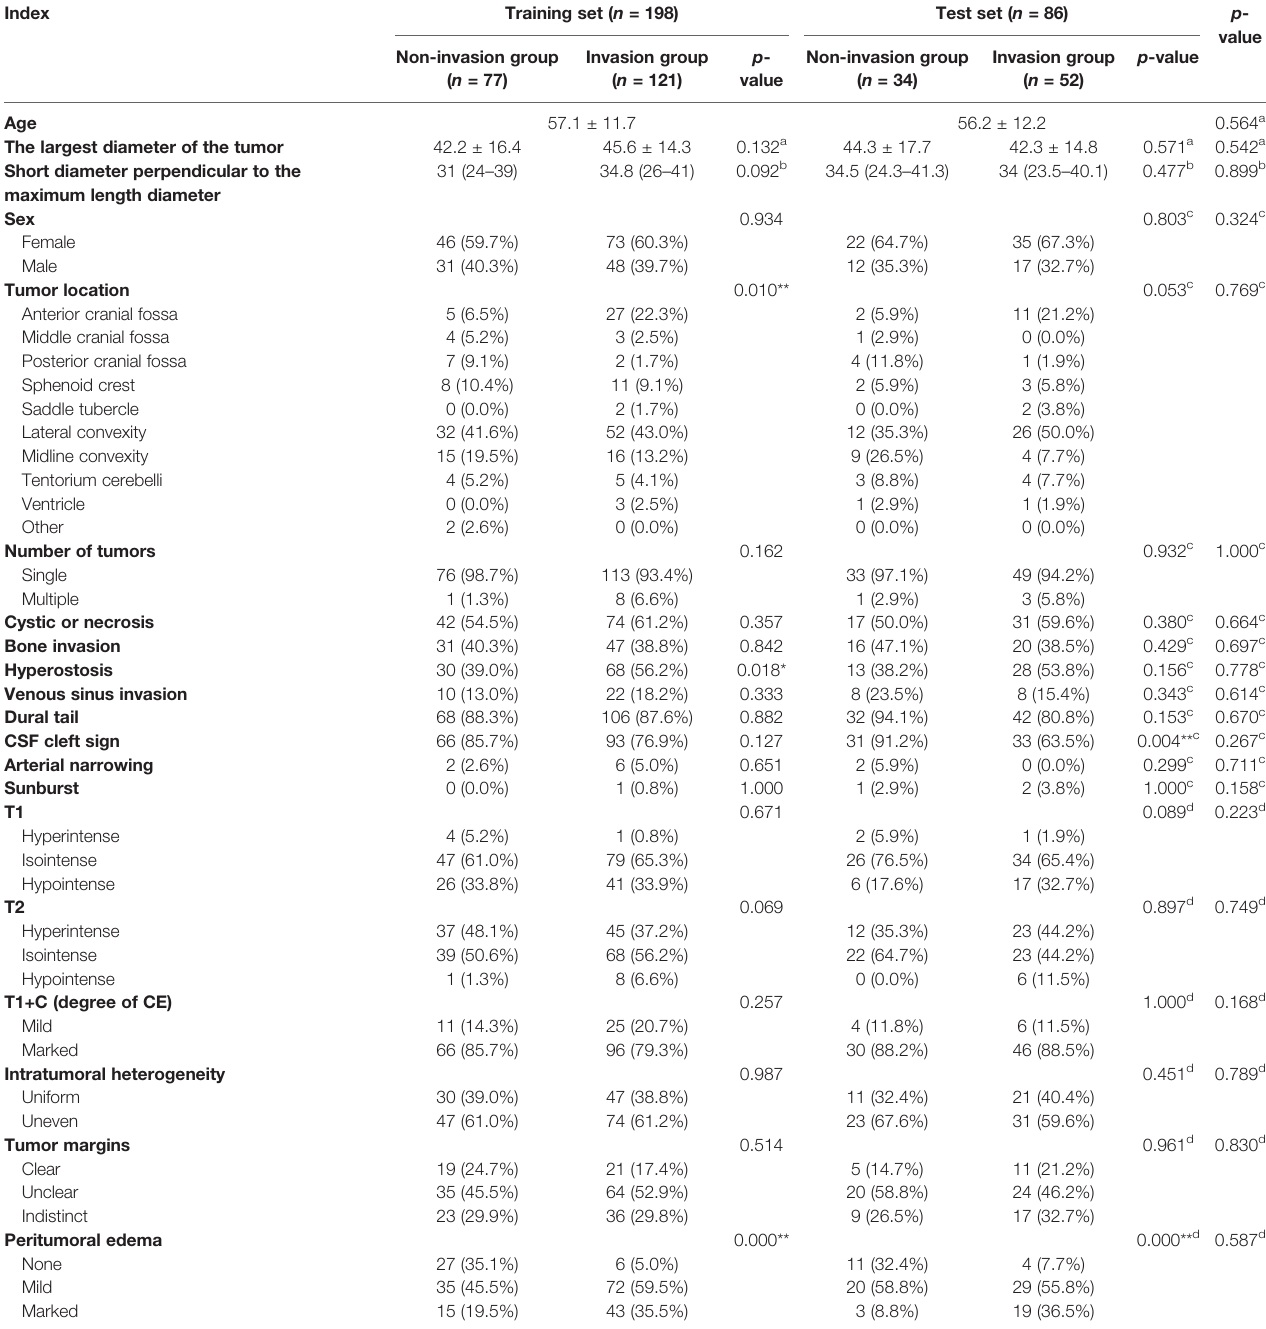
TABLE 2 | Demographic information of meningioma patients in the training set and test